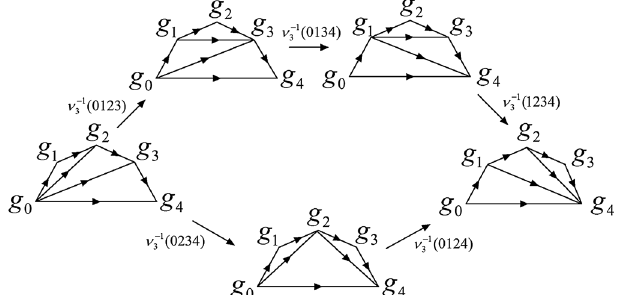
FIG. 1. The self-consistent equation on a big patch. The branching structure on this patch is induced by a local direction from left to right. Mathematically, it is known as the 3-cocycle